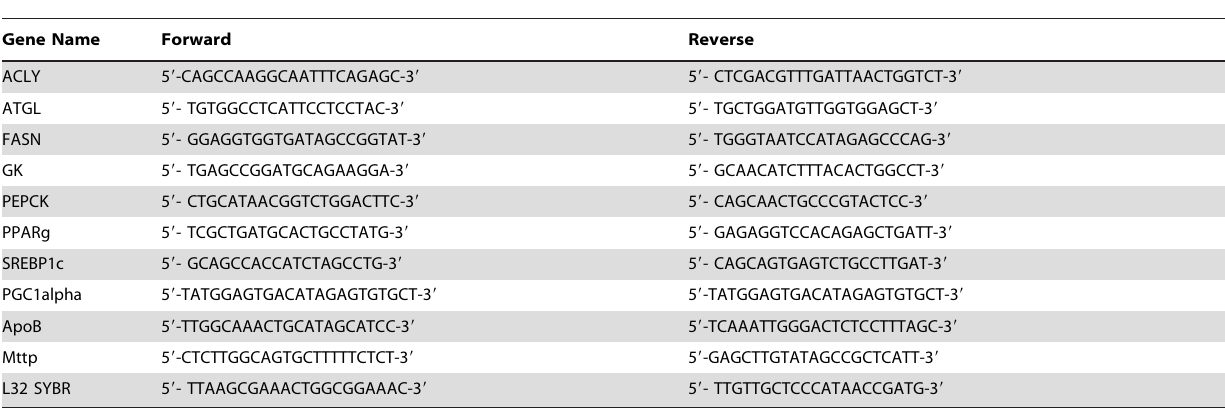
Table 1. Primer sequences used in